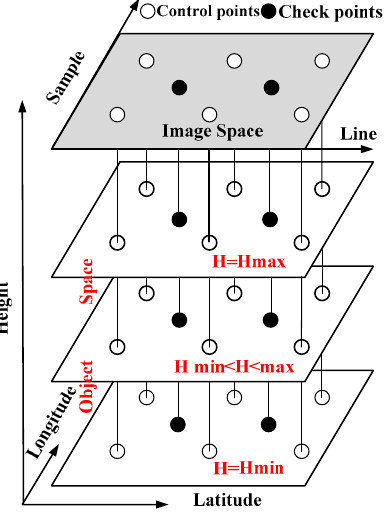
Figure 6. The schematic diagram of the virtual control points and check points. Table 3. Statistical results comparison of the RPCs fit using a smooth attitude.